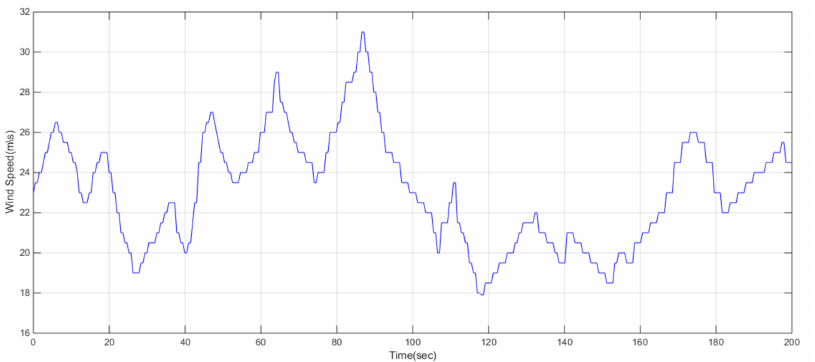
Figure 1. Wind speed 17 w 32 (m/s).